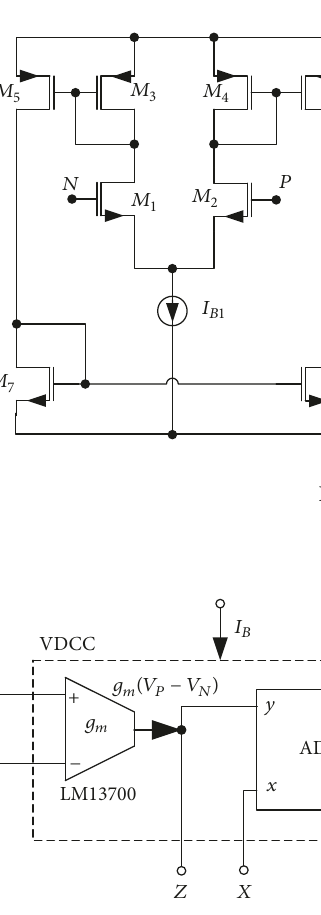
Figure 3: VDCC (without dual 𝑊 terminal) constructed from commercially available